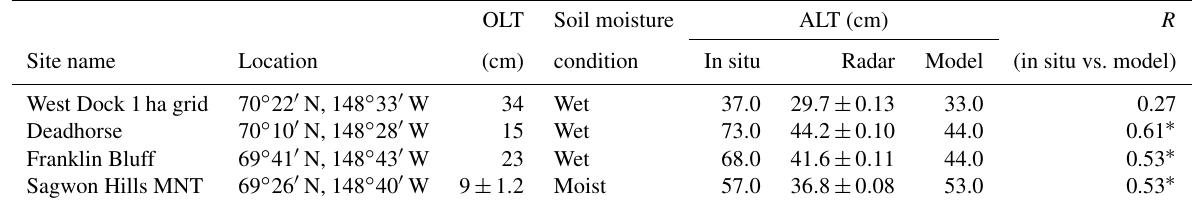
Table 2. In situ CALM sites covered by the UAVSAR and AirMOSS airborne radar flights along the Dalton Highway (DH) in October 2015. The information on OLT and soil moisture conditions was obtained from in situ site measurements. The local-scale ( ∼ 50m resolution) radar ALT retrievals were averaged within an 18 × 18 pixel window ( ∼ 1km × 1km) to compare with the 1km soil model ALT simulations. The correlations ( R ) between the in situ observations and model ALT estimates were calculated for the 2001–2015 study period. OLT Soil moisture ALT (cm)